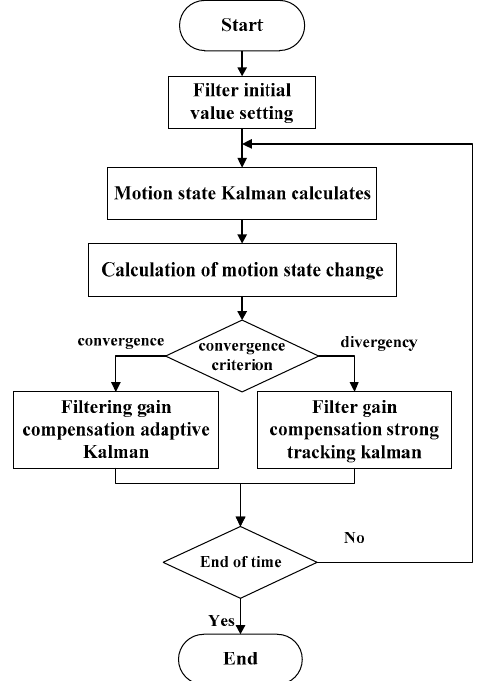
Figure 2. Workflow of the filtering gain compensation adaptive filter.